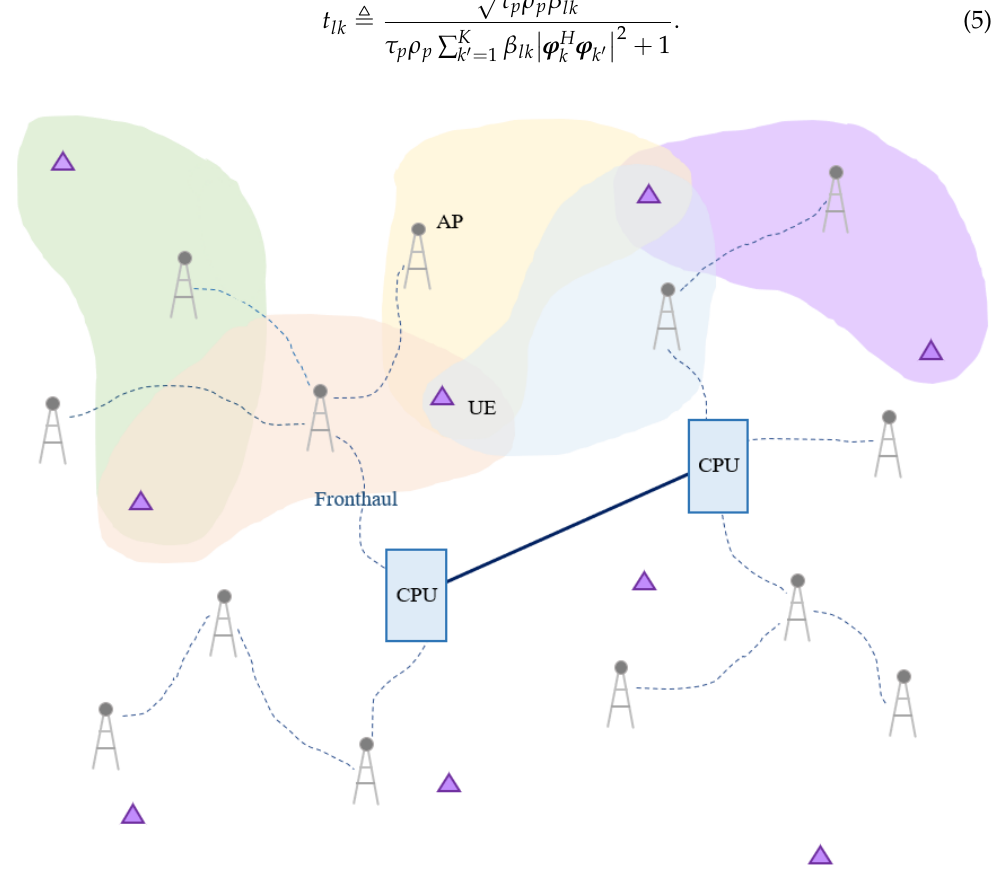
Figure 1. Network model of user-centric cell-free massive MIMO